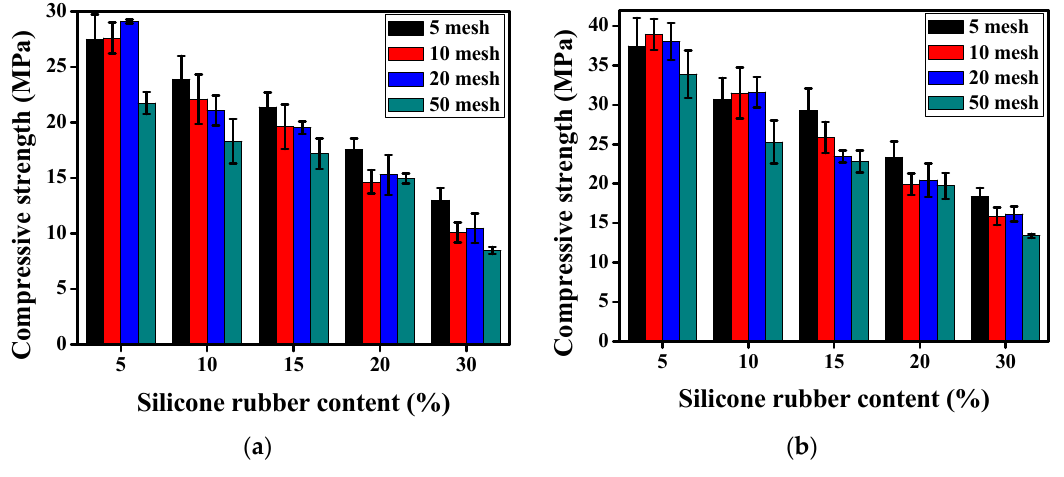
Figure 8. The compressive strength of the silicone rubber mortar. ( a ) 7-days; ( b ) 28-days.